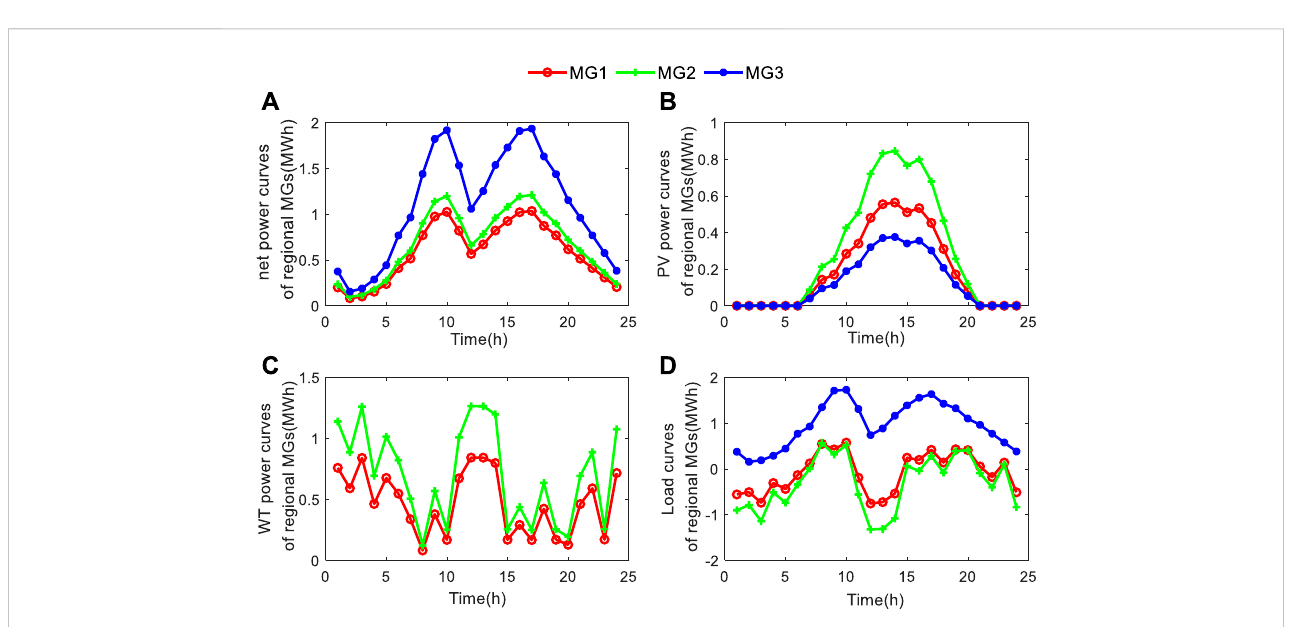
FIGURE 3 Initial data of microgrid in each region: (A) Total load of microgrid in each region; (B) Photovoltaic output of microgrid in each region; (C) Output of microgrid fans in each region; (D) Net load of microgrid in each